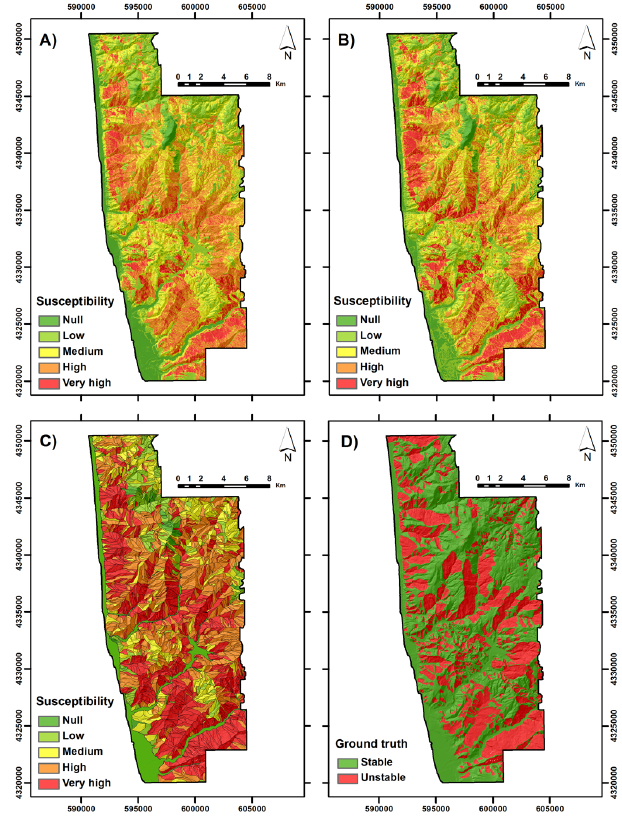
Fig. 11. Visual comparison between best susceptibility maps ob- tained with: (A) square cells and grouped variables, (B) square cells and dummy variables, (C) slope units and dummy variables; and ground truth (D) .